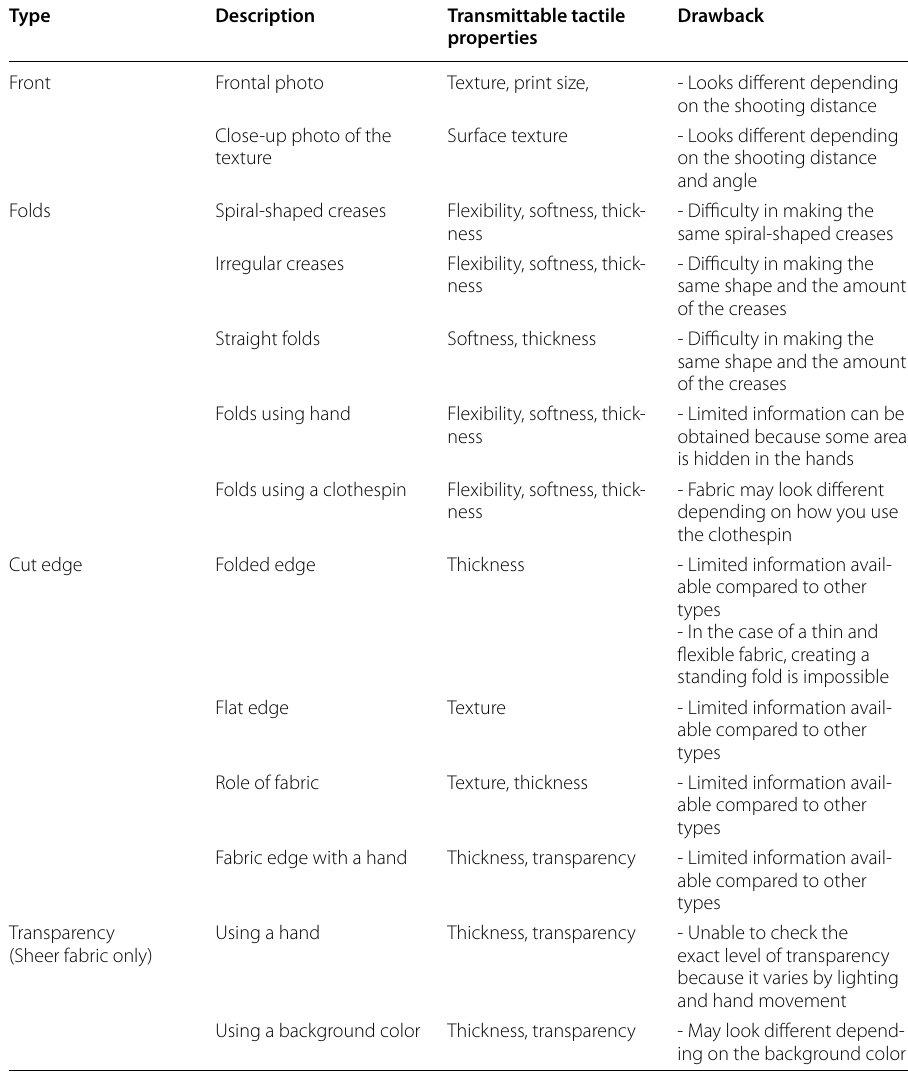
Table 3 Types of visual information and overall perspectives of participants (the preferred methods are highlighted in